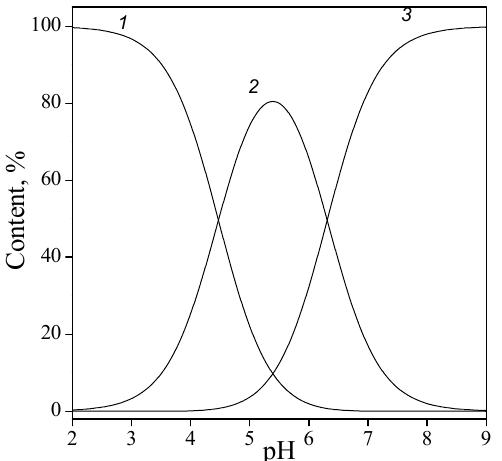
Figure 4. Solution speciation of cytidine-5 ′ -monophosphate: zwitterion H 2 L ± ( 1 ), monoanion HL – ( 2 ), and dianion L 2– ( 3 ).